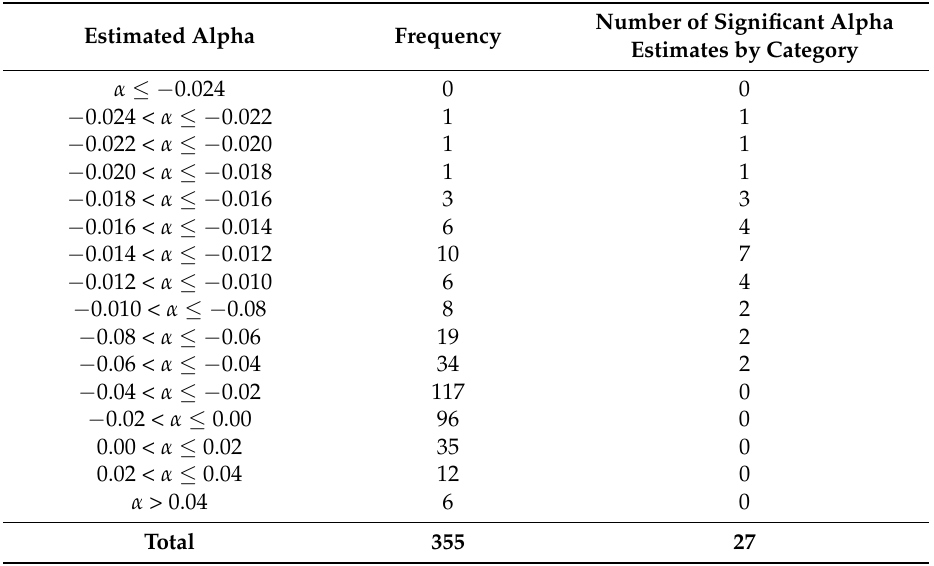
Table 2. Distribution of Jensen’s alpha estimates across 355 funds between April 2011 and April 2016. Estimated